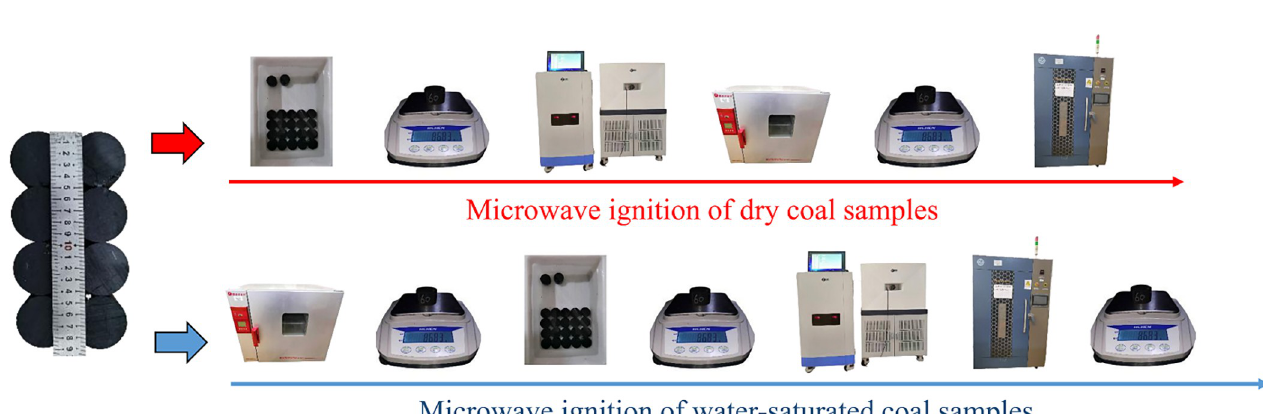
Fig 4. Experimental